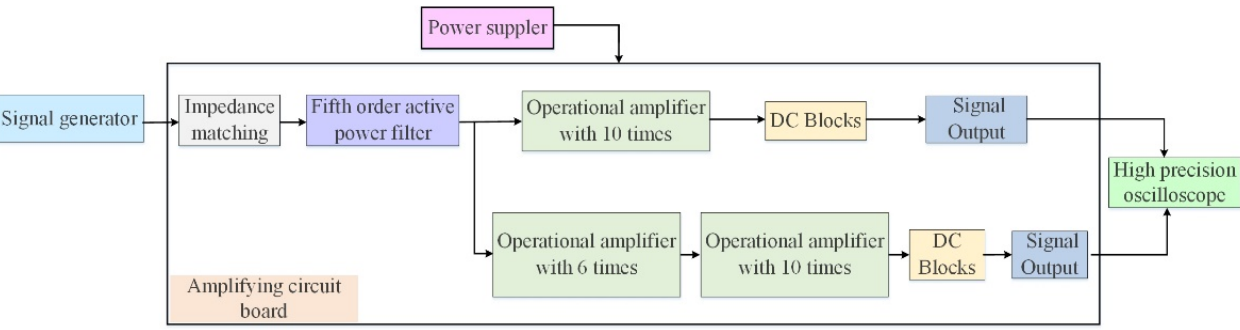
Figure 13. Schematic diagram of optimized ACB linearity test.